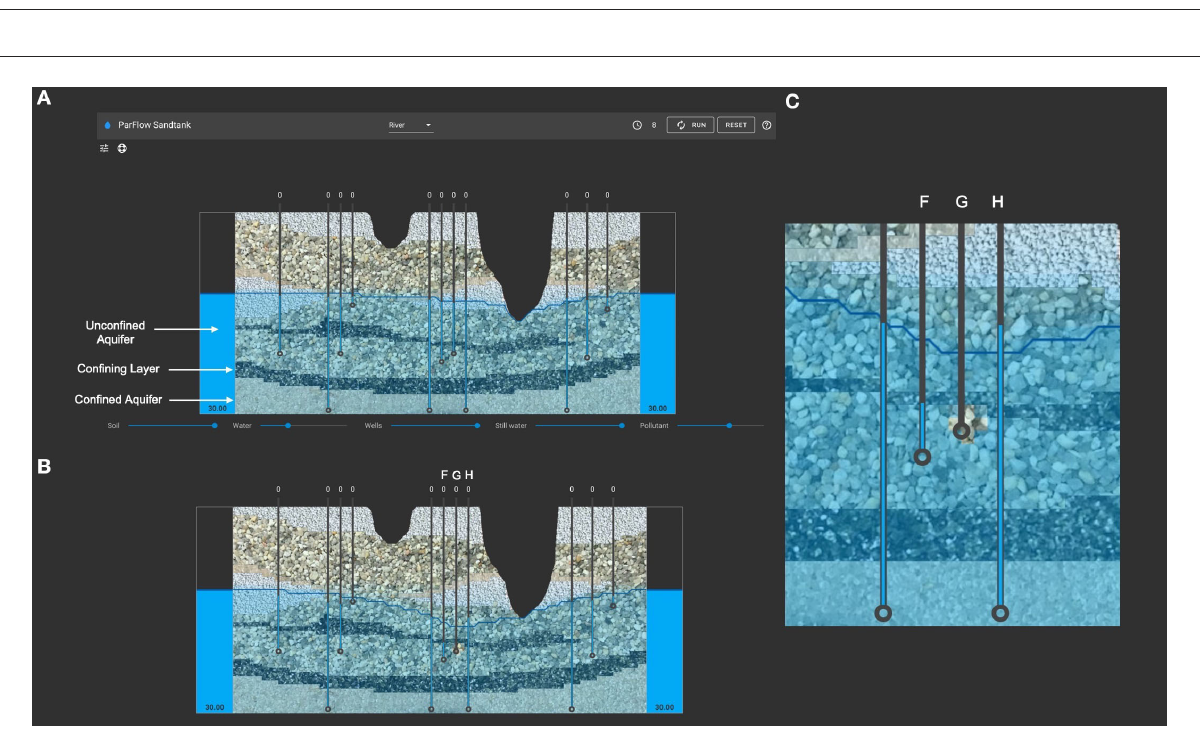
FIGURE6 Mx. Garcia’s demonstration of the water table responding to changing input. (A) Initial conditions. (B) Water table after user input adjustment and one timestep. (C) After removing the geologic materials the users can see saturation conditions in the PFST.